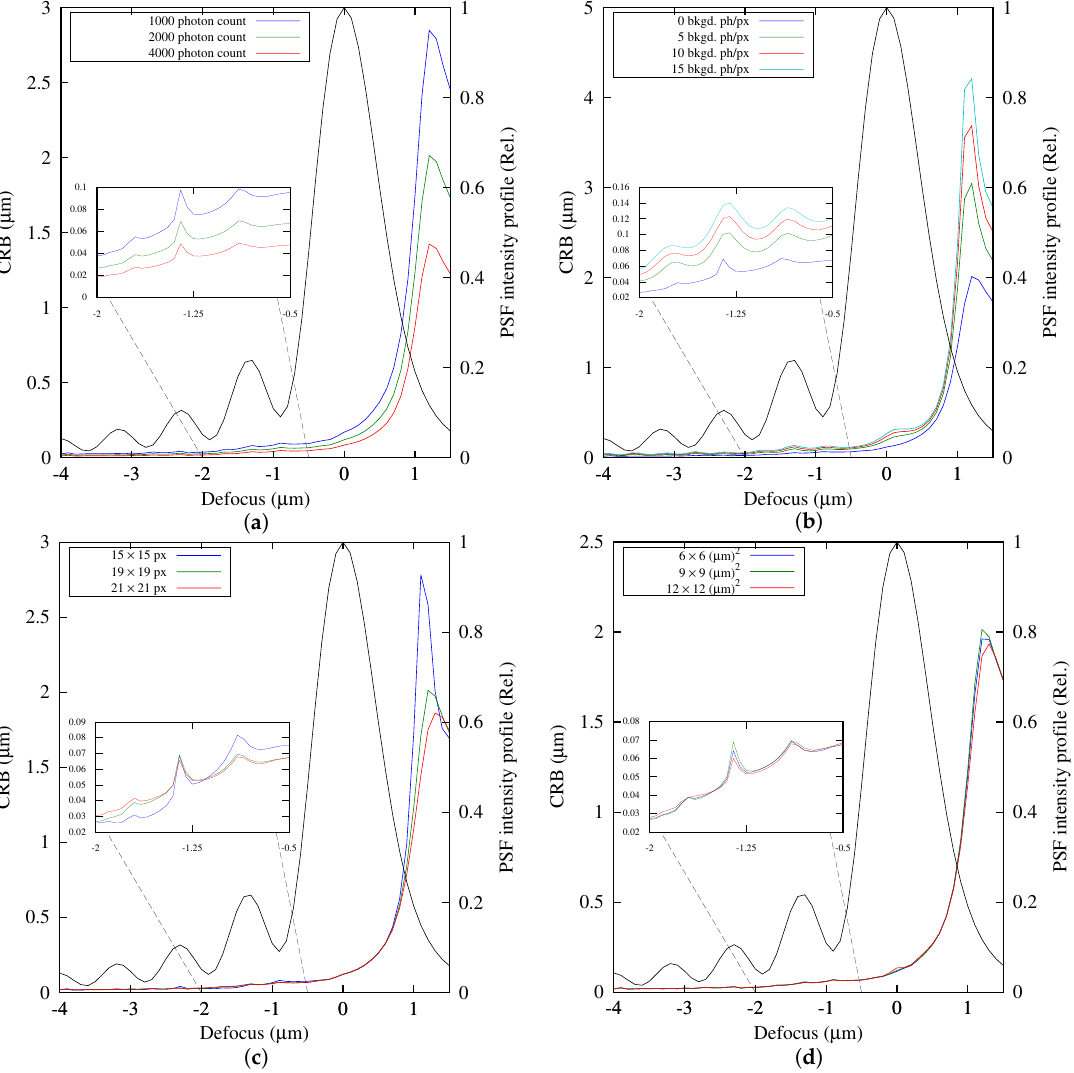
Figure 2. Cramer–Rao lower bound computed with Equation (20) for the noisy point spread function (PSF) model given by Equation (5) under several acquisition conditions. In black, the theoretical PSF intensity axial profile for reference. ( a ) CRB versus photon number; ( b ) CRB versus background; ( c ) CRV versus pixel number; ( d ) CRB versus pixel